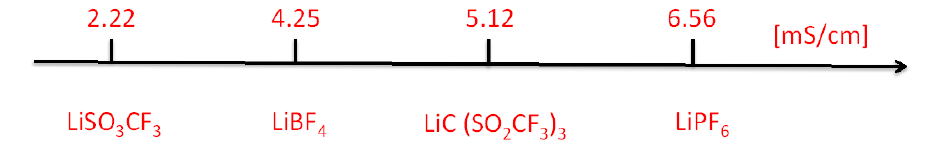
Figure 4. Comparison of various electrolytes for lithium-ion batteries based on conductivity [56].